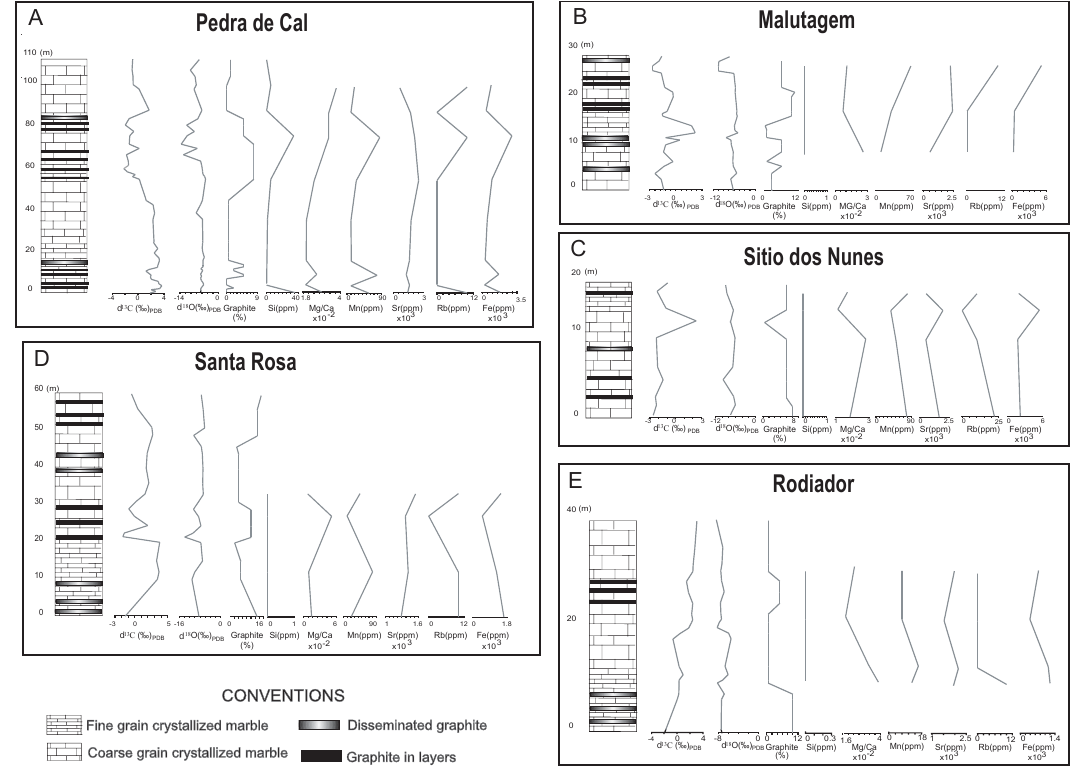
Fig. 5 – C- and O- isotope chemostratigraphic pathways for the studied marble successions. Note the inverse relationship between the δ 13 C stratigraphic trends and variations in the graphite content. Elemental stratigraphic variations are also